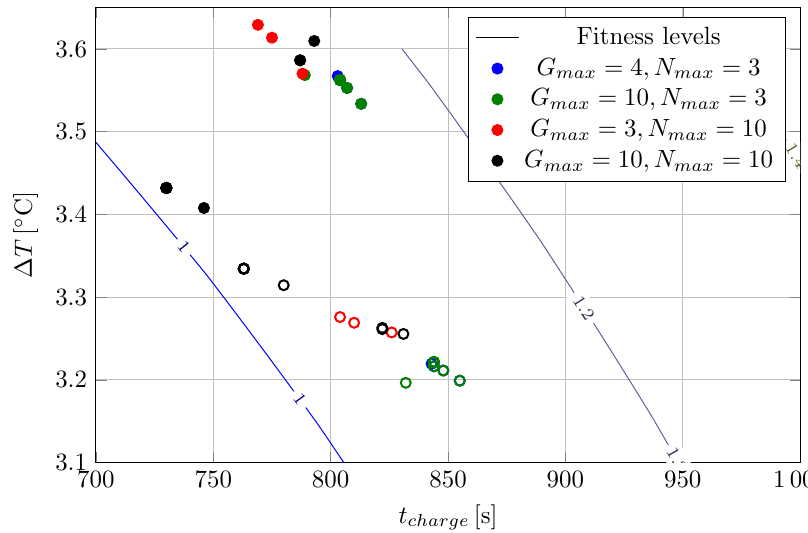
∆ T plane. The four −